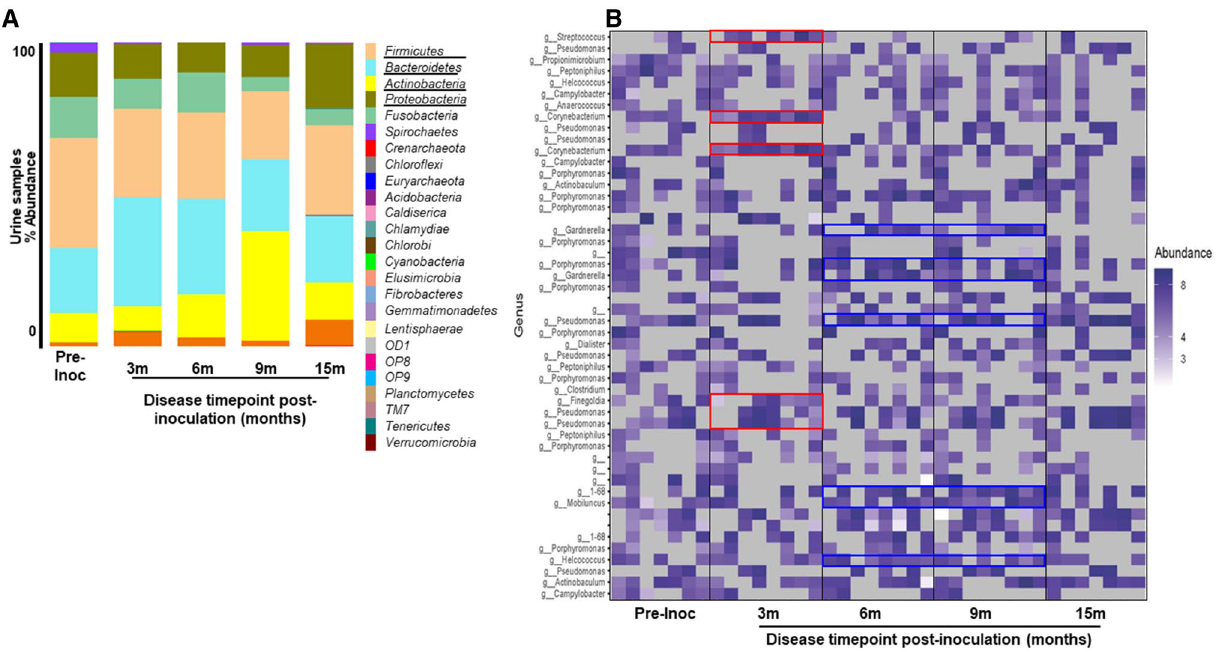
Figure 6. Taxonomical analysis for urine samples of 8 non-human primates from pre- and post-inoculation of endometriosis. ( A ) Level 2 (phyla) taxonomical summary plots. ( B ) The top 50 abundant bacterial genera in urinary tract. Samples were collected from animal at the pre-inoculation (pre-inoc) (left panel) and following disease induction (right